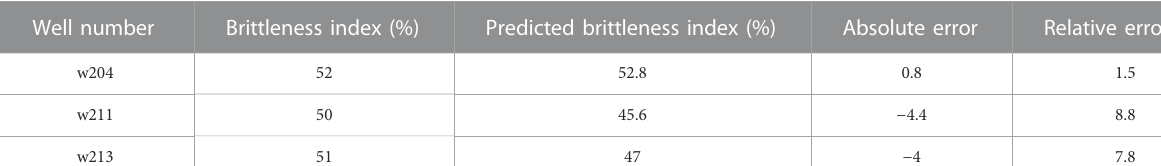
TABLE 6 Statistical table of the prediction error of high-quality shale brittleness index.